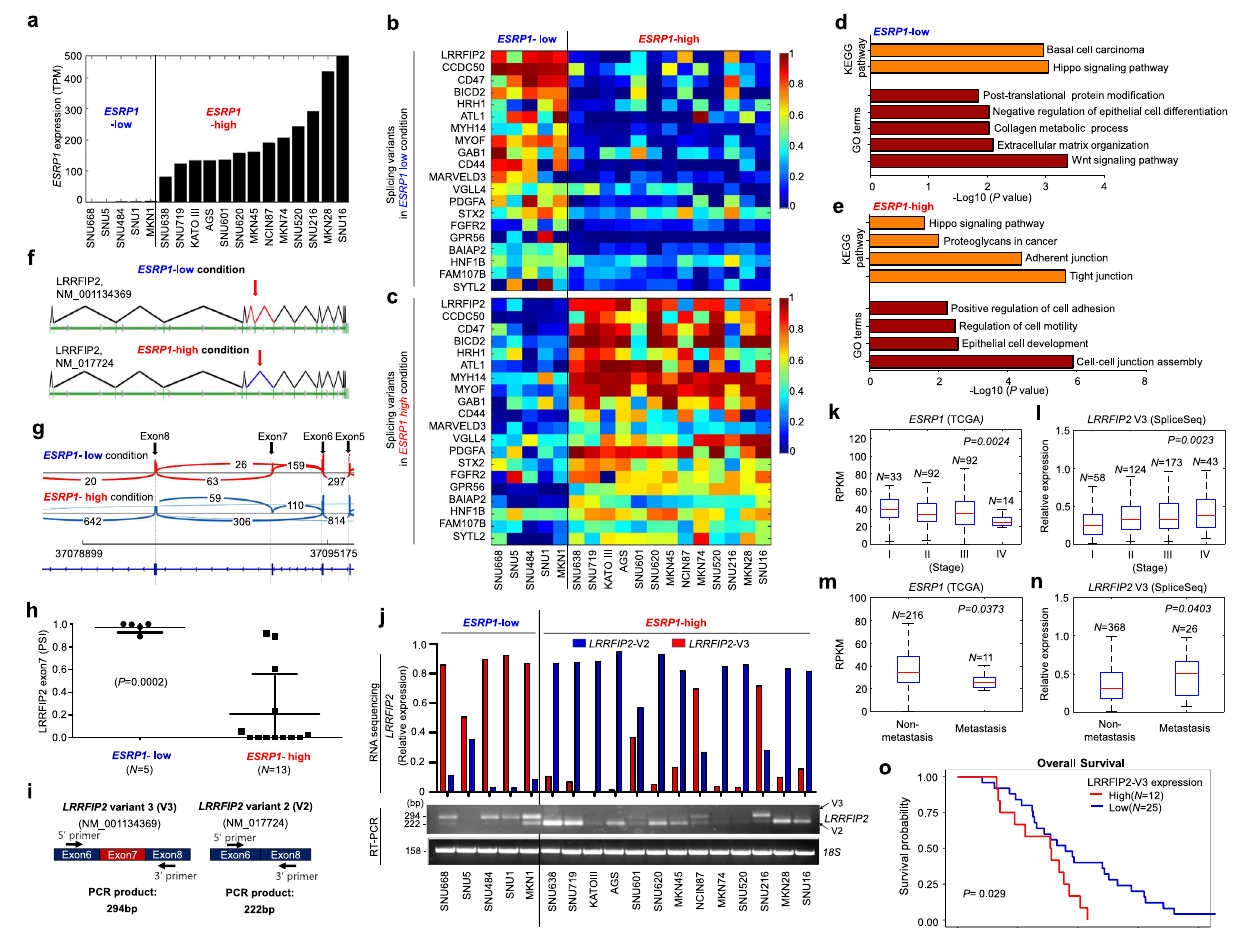
LRRFIP2 variant 2 (shown in red) and variant 3 (shown in blue) in 18 gastric cancer cell lines. k – n Box plots showing ESRP1 and LRRFIP2 variant 3 expression levels in gastriccancertissuesfrompublicTCGAdatasets, k,l incancerstagesI-IVand m,n in non-metastatic versus metastatic gastric cancers. The center line is the median; theboxisfromthe25thtothe75thpercentile.Theupperorlowerwhiskerextends fromthehingetothe1.5xIQR(distancebetweenthe fi rstandthirdquartiles)from thehingeforupandlow,respectively. o AplotshowingKaplan-Meiercurveswhich represent the overall survival differences between patients who had highly up- regulated LRRFIP2 variant 3 ( LRRFIP2 -V3) expression levels in tumors compared to their matched normal tissues ( ≥ 2-fold) ( N =12) and other patients ( N =25) in the stage IV gastric cancer dataset. Overall survival was de fi ned as the time (months) from the diagnosis date of stage IV to death. P value for h was calculated by unpairedtwo-tailedStudent ’ sttests. P valuesfor k – o werecalculatedfromthelog- rank test. Source data are provided in the Source Data fi